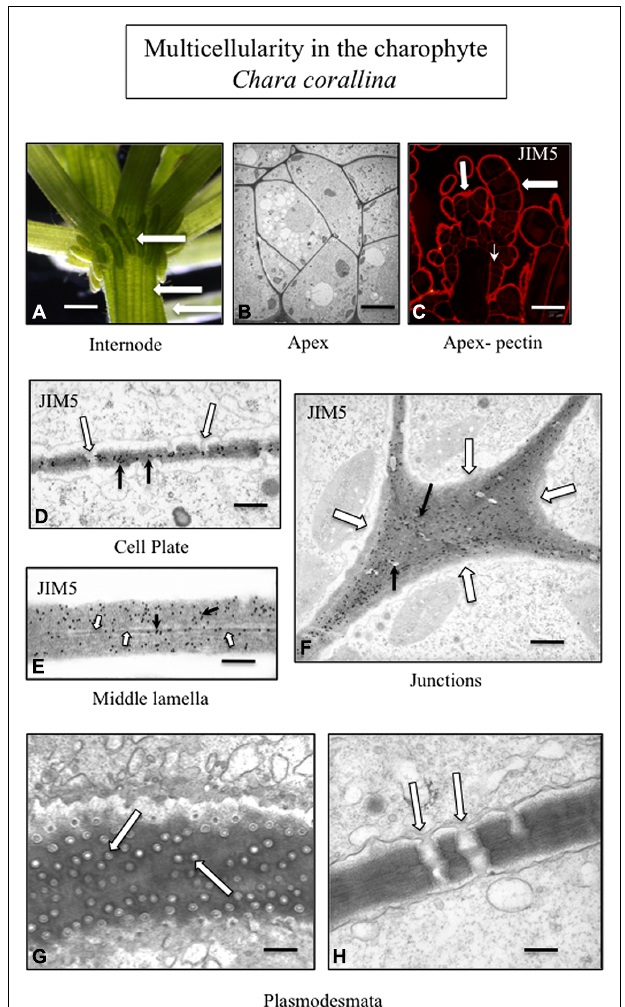
FIGURE 3 | Multicellularity in the charophyte Chara corallina. The thallus consists of filaments tightly appressed to each other ( A ; arrows; LM; bar = 600 μ m).TEM imaging highlights the tight packing of the cells of the thallus ( B ; bar = 4 μ m).The cell walls of the outer cells of the thallus (large arrows) and the cross walls (small arrow) label with JIM5 ( C ; CLSM; bar = 200 μ m).TEM immunogold labeling with JIM5 (black arrows) of a developing cell plate during cytokinesis. In addition, plasmodesmata (white arrows) are forming during this stage of the cell division ( D ; bar = 100 nm). The wall–wall zone of adjacent cells labels with JIM5 ( E ; white arrows; TEM; bar = 80 nm) and the middle lamella is also apparent (black arrow). The cell walls of the junction zone between cells ( F ; white arrows;TEM; bar = 400 nm) label intensely with JIM5. In the thallus, multiple plasmodesmata penetrate the cell walls and connect adjacent cells ( G, H ; arrows;TEM; G bar = 200 nm; H bar = 300 nm).